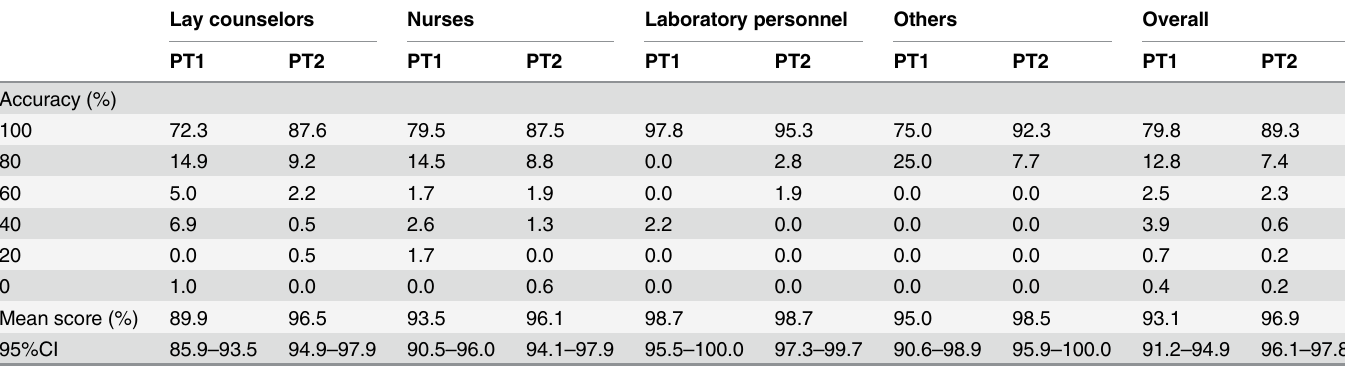
Table 2. Proportion of tester groups who achieved a specified level of accuracy in PT1 and PT2.